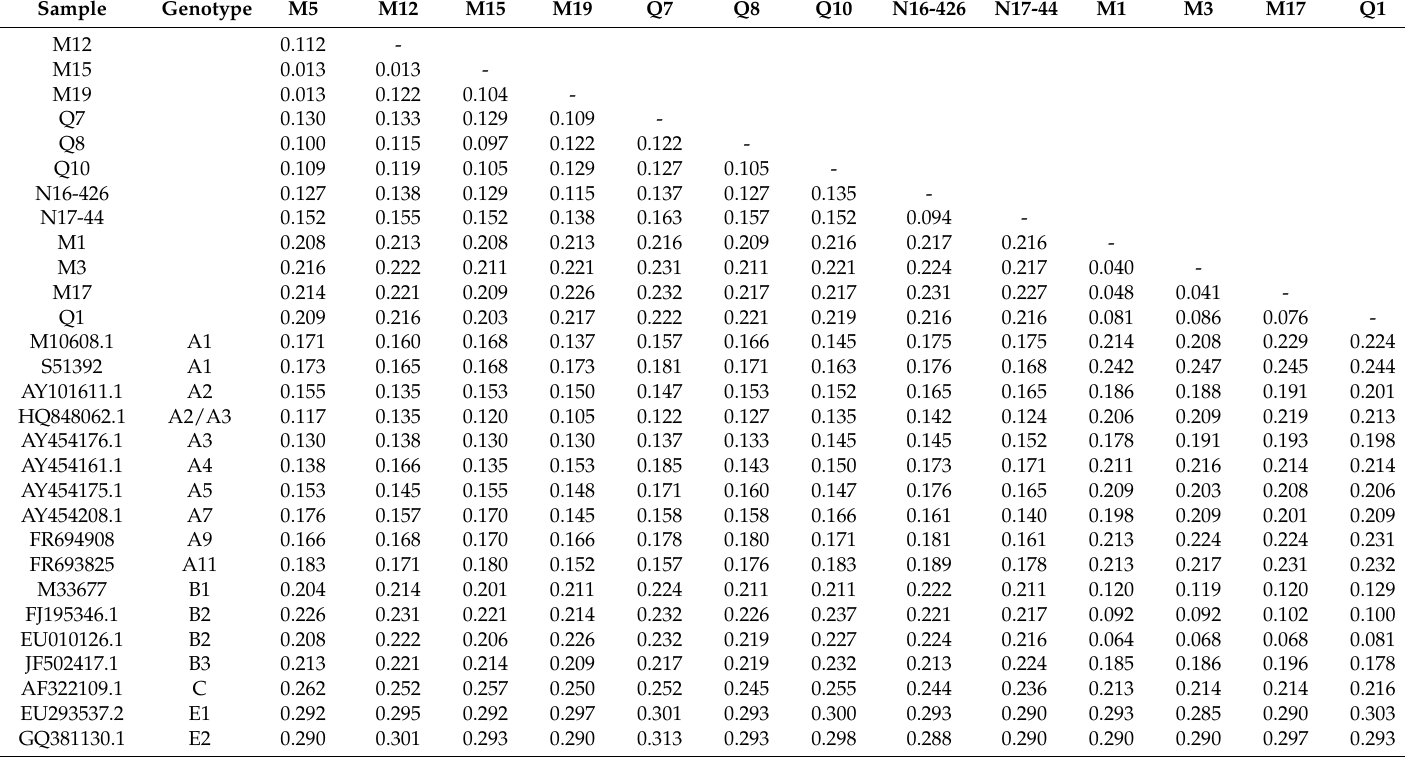
Table 2. Pairwise nucleotidic genetic distances (p-distance model) of the partial gag-pol region of some SRLV reference strains and SRLV strains sequenced in this